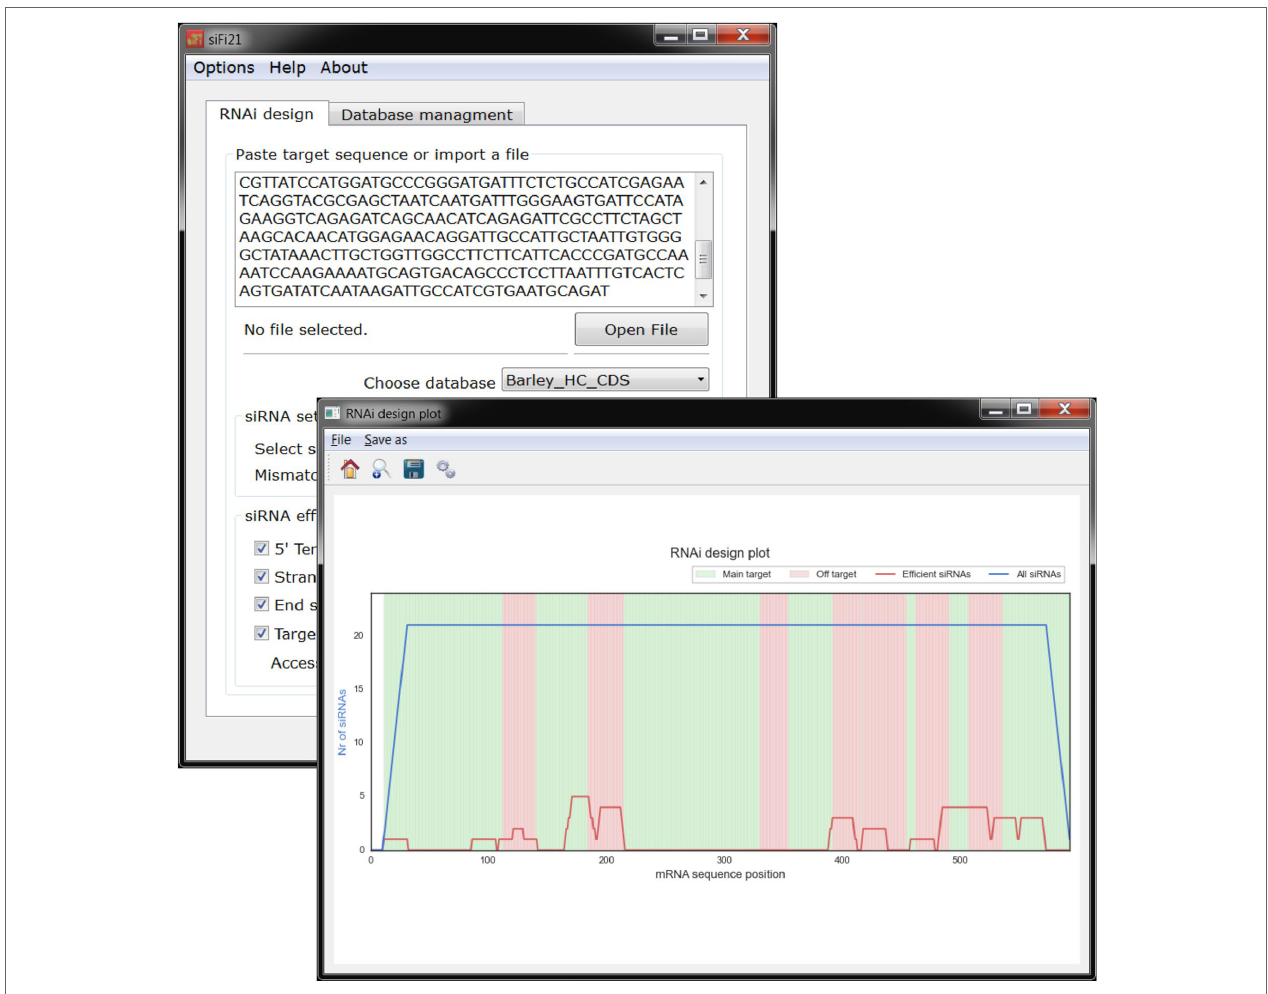
FIGURE 6 | si-Fi21 screenshots and example results of the RNAi design mode. The blue line indicates the total number of siRNA hits; the red line corresponds to the number of siRNA hits that match the selected criteria for efficiency; the red zone indicates the regions that may cause silencing of genes that were not selected as a target; in the green zone are the regions that have no match to other genes besides the selected